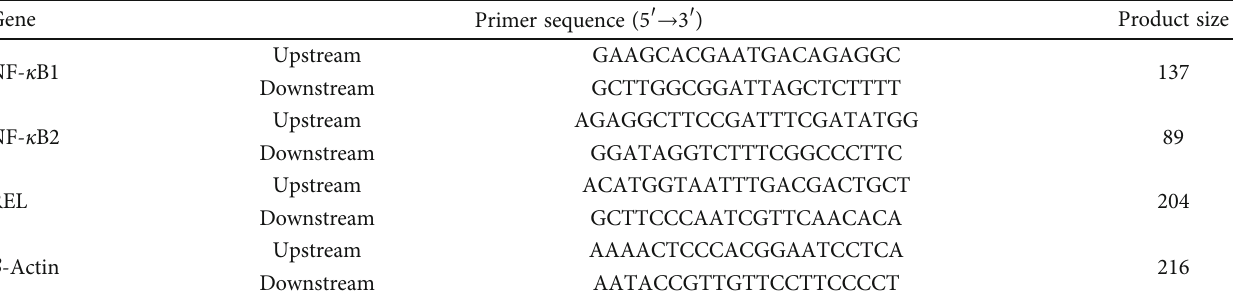
Table 1: Quantitative primer information of target gene.